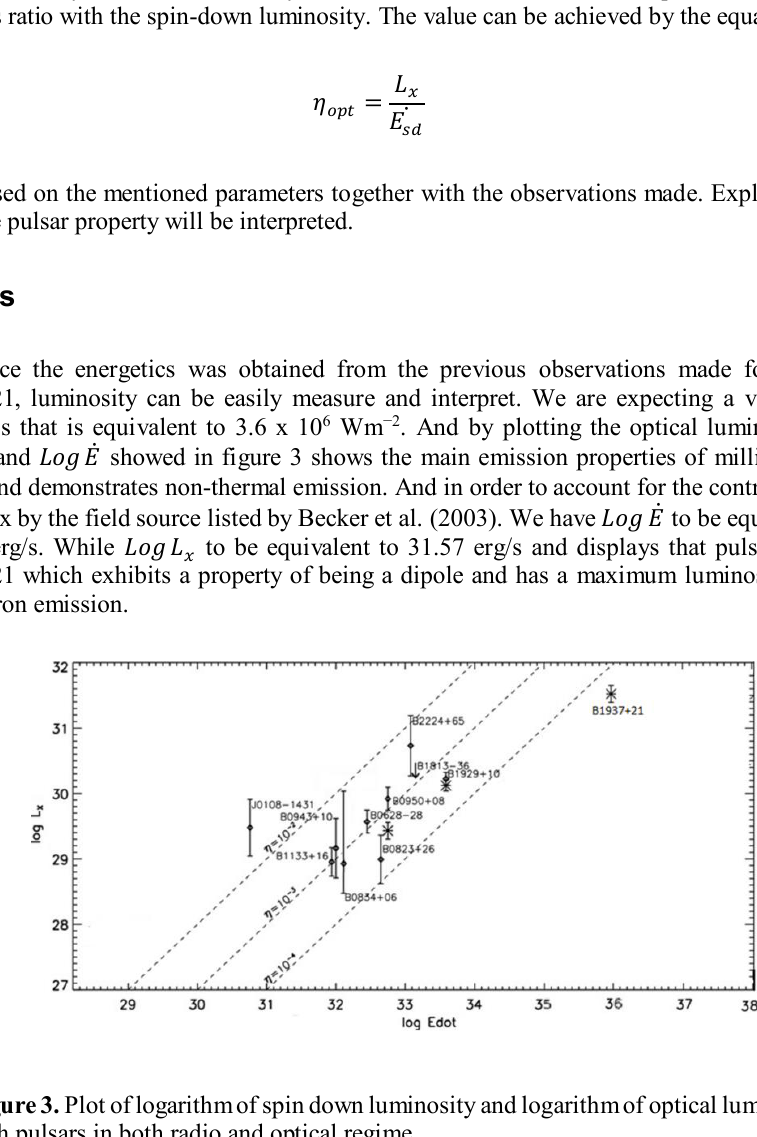
Figure 3. Plot of logarithm of spin down luminosity and logarithm of optical luminosity with pulsars in both radio and optical